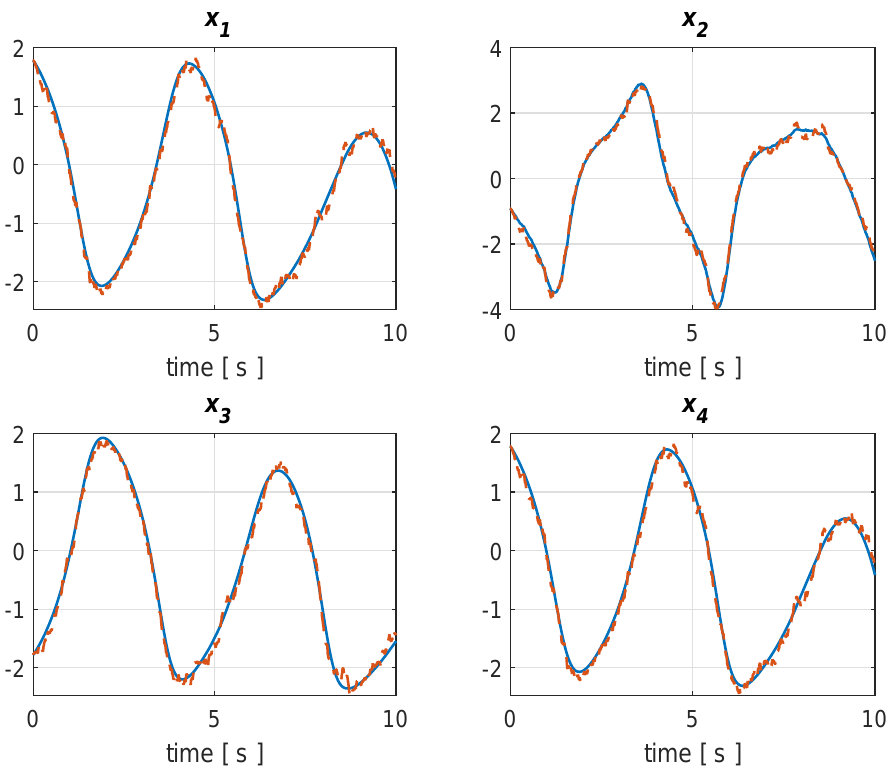
Figure 4. Simulation run at regime with uniformly distributed noises w i , i = 1,2,3,4, in [ − 1,1 ] , x ( 0 ) = ˆ x ( 0 ) = ( 1.7809, − 0.9185, − 1.7809,1.7809 ) , where the state variables are in blue and their estimates are in dashed